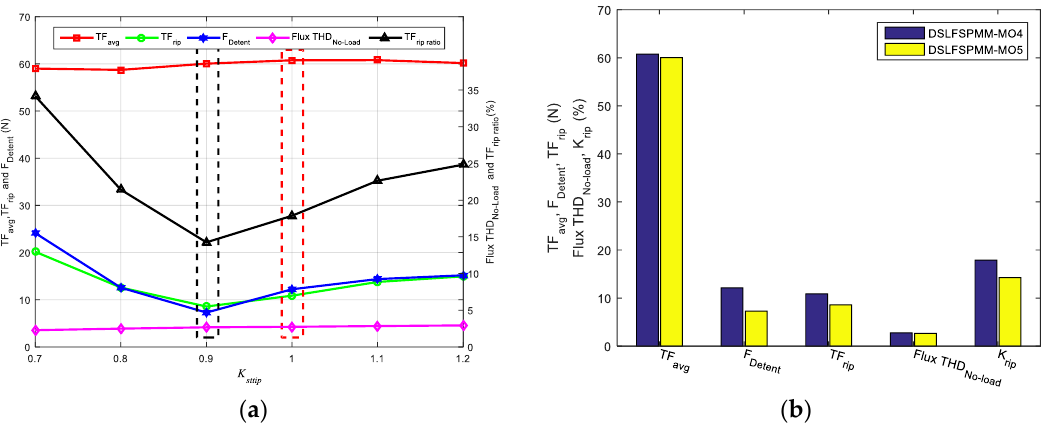
Figure 17. Stator tooth tip width optimization: ( a ) Performance comparison of DSLFSPMM-MO4 having different 𝐾 𝑠𝑡𝑡𝑖𝑝 values; ( b ) Performance comparison of DSLFSPMM-MO4 and DSLFSPMM-MO5. Table 11. Modified parameter and performance comparison of DSLFSPMM-MO4 with DSLFSPMM-MO5.